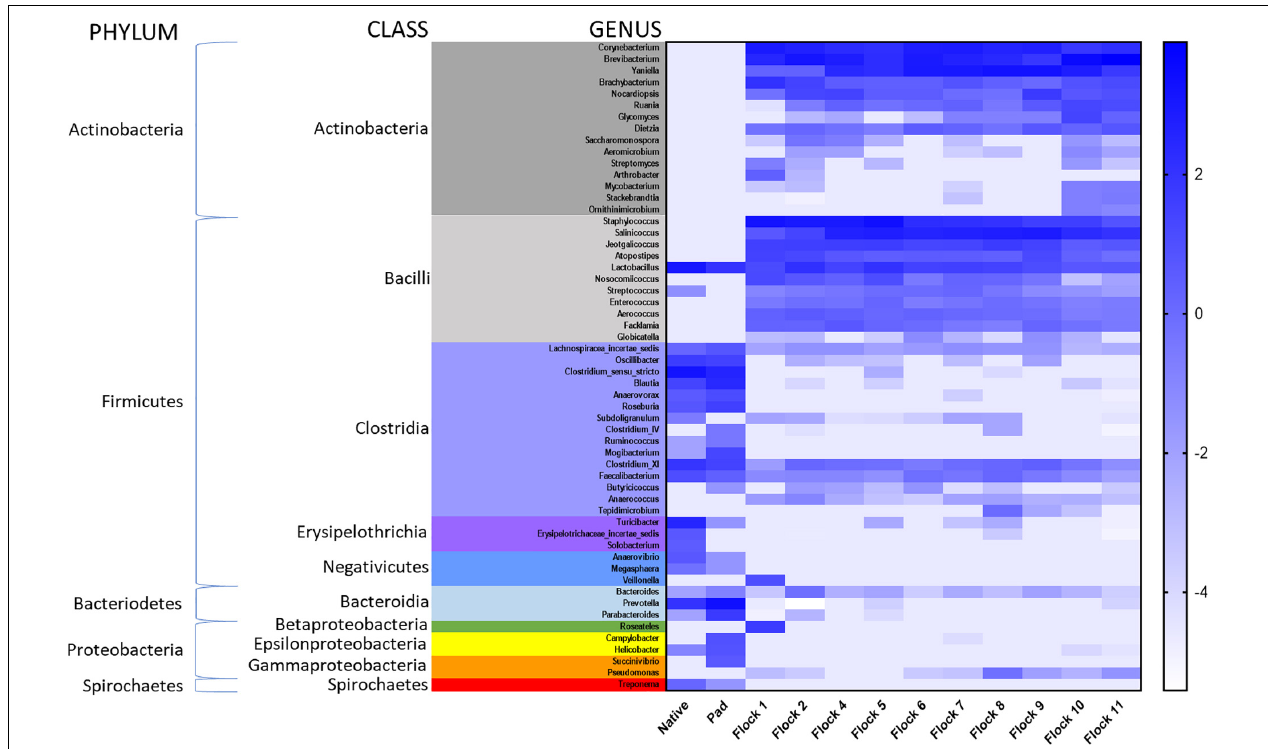
FIGURE 4 | A heat map of natural log transformed quantity of genera identified sequences grouped by Class collected from Native, PAD and Flock rotation samples.